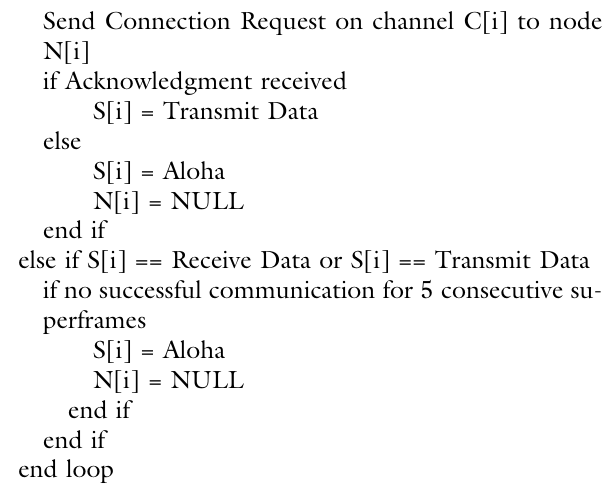
Algorithm 2: Reservation-Based